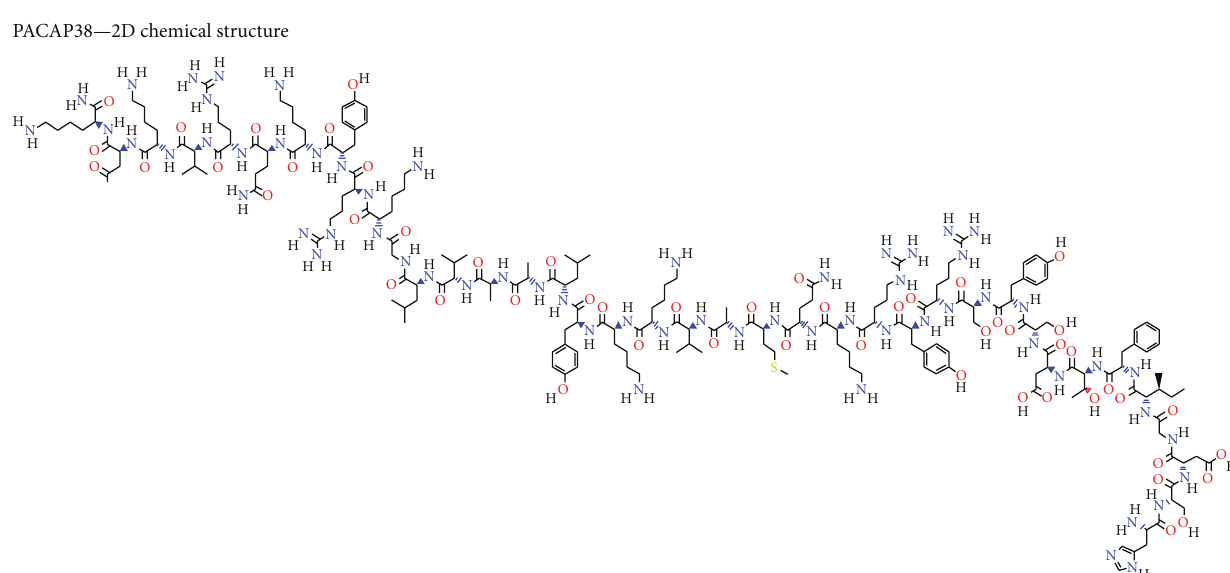
Figure 1: 2D chemical structure of full-length PACAP38 (CID 44566111). The chemical structure was retrieved using the publicly available PubChem database source, accessible at